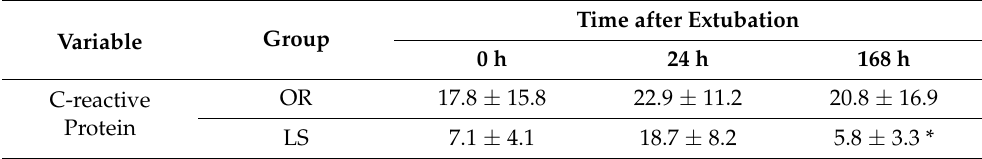
Time after Extubation 0 h 168 h